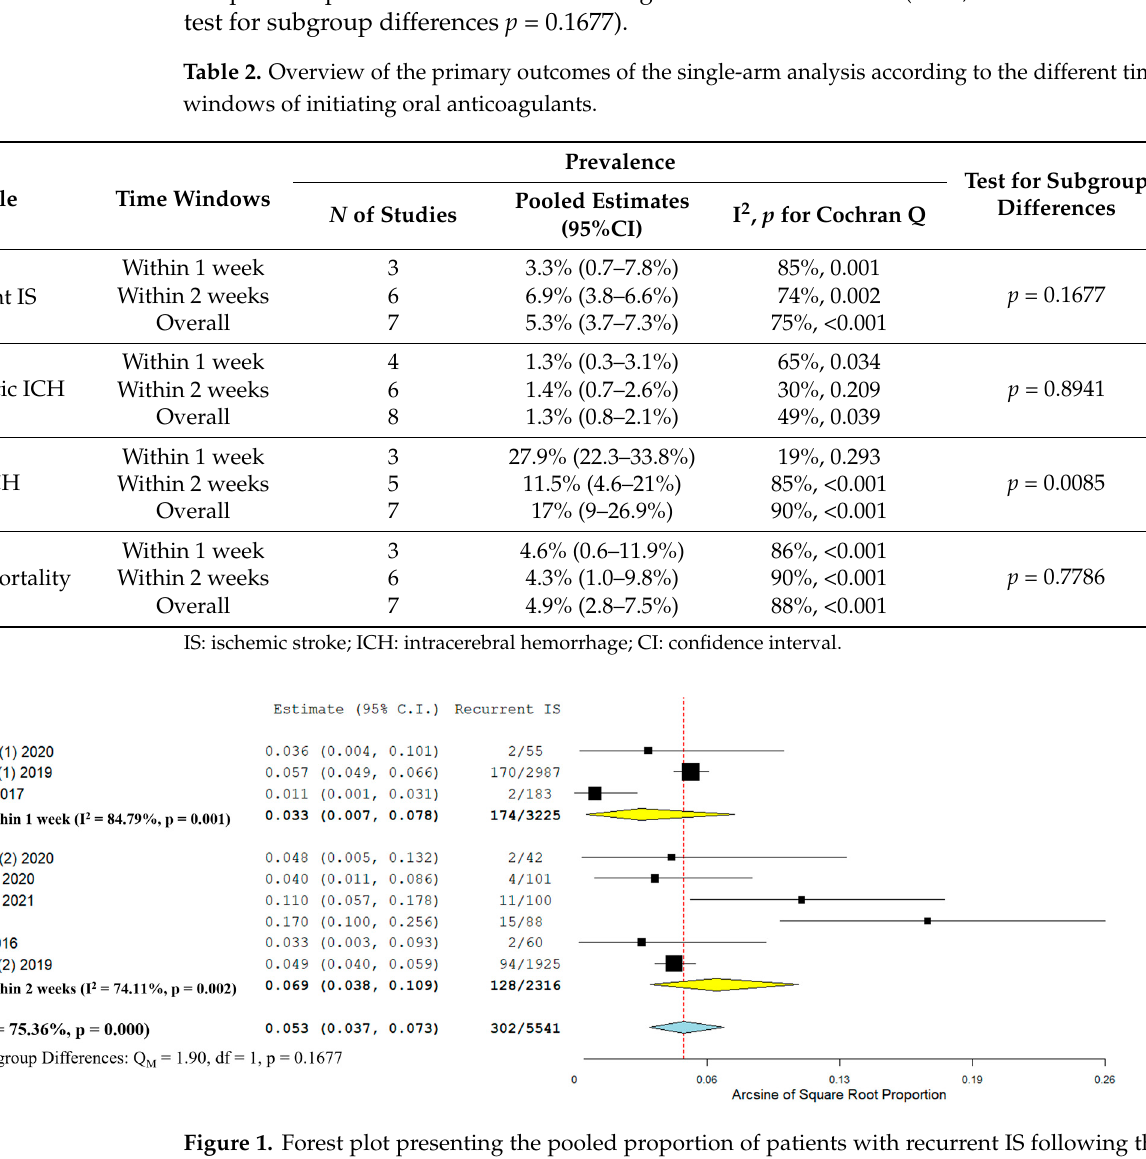
Figure 1. Forest plot presenting the pooled proportion of patients with recurrent IS following the initiation of oral anticoagulants, stratified by the timing of treatment initiation [10,11,18–21,23]. sICH was present in 1.3% of the patients (95%CI: 0.8–2.1%; 8 studies; I 2 = 49%; p for Cochran Q = 0.039; Supplementary Figure S4). Importantly, no subgroup differences be- tween the two different time windows were disclosed ( p for subgroup differences =